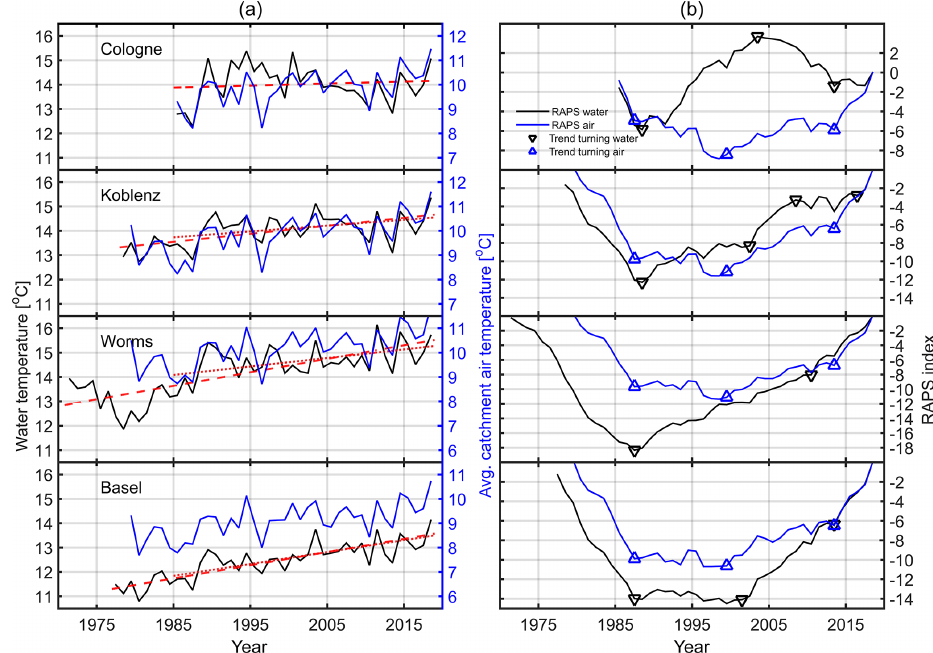
Figure 5. (a) Yearly averages of water temperatures at the four monitoring stations (black line). The red dashed line is a fit to the available data set. The red dotted line is a fit to the overlapping time period (1985–2018). The blue line is the yearly average air temperature of the catchment area. (b) RAPS T w (black) and T a (blue) indexes. The triangle markers divide the RAPS index into sections, based on a slope change in the RAPS index. Each section also represent a trend change in the original T a and T w time